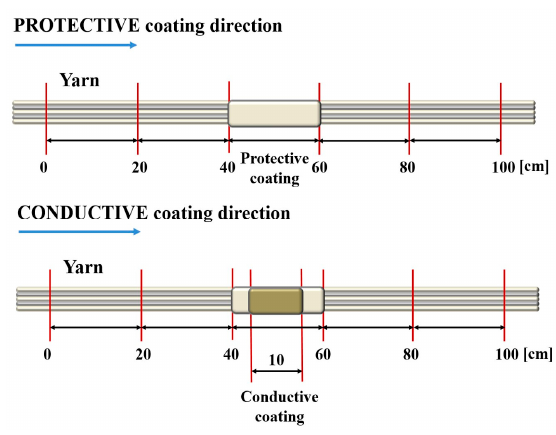
Figure A2. Coloured pen usage to mark given distance at sole yarn surface—scheme [53].